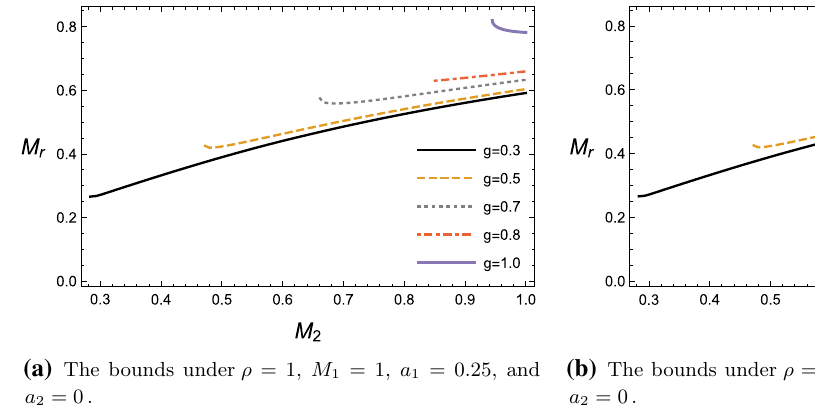
Fig. 13 The upper bound on the radiation with respect to g